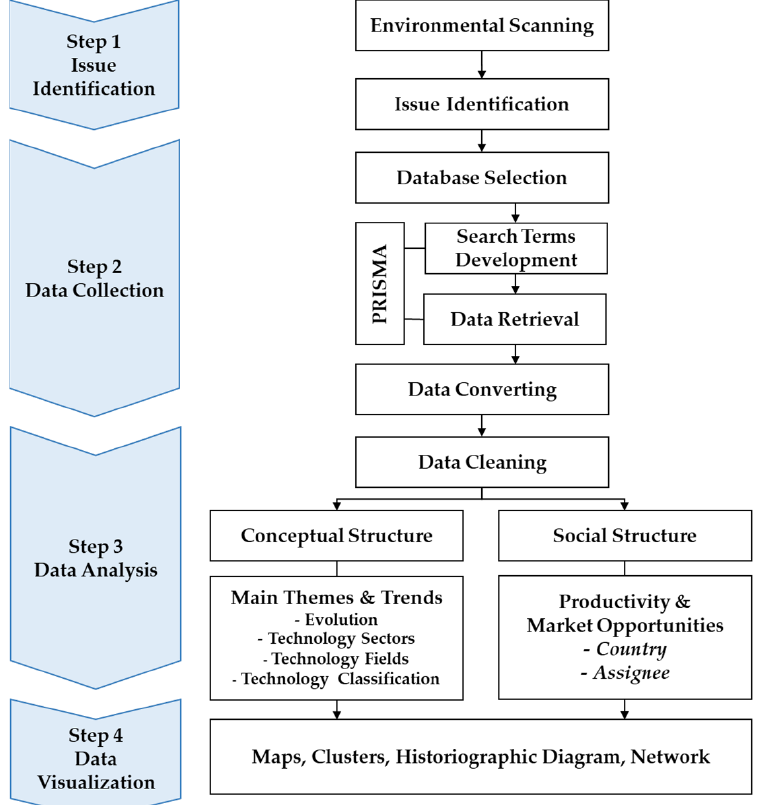
Figure 1. The framework of scientometric analysis.